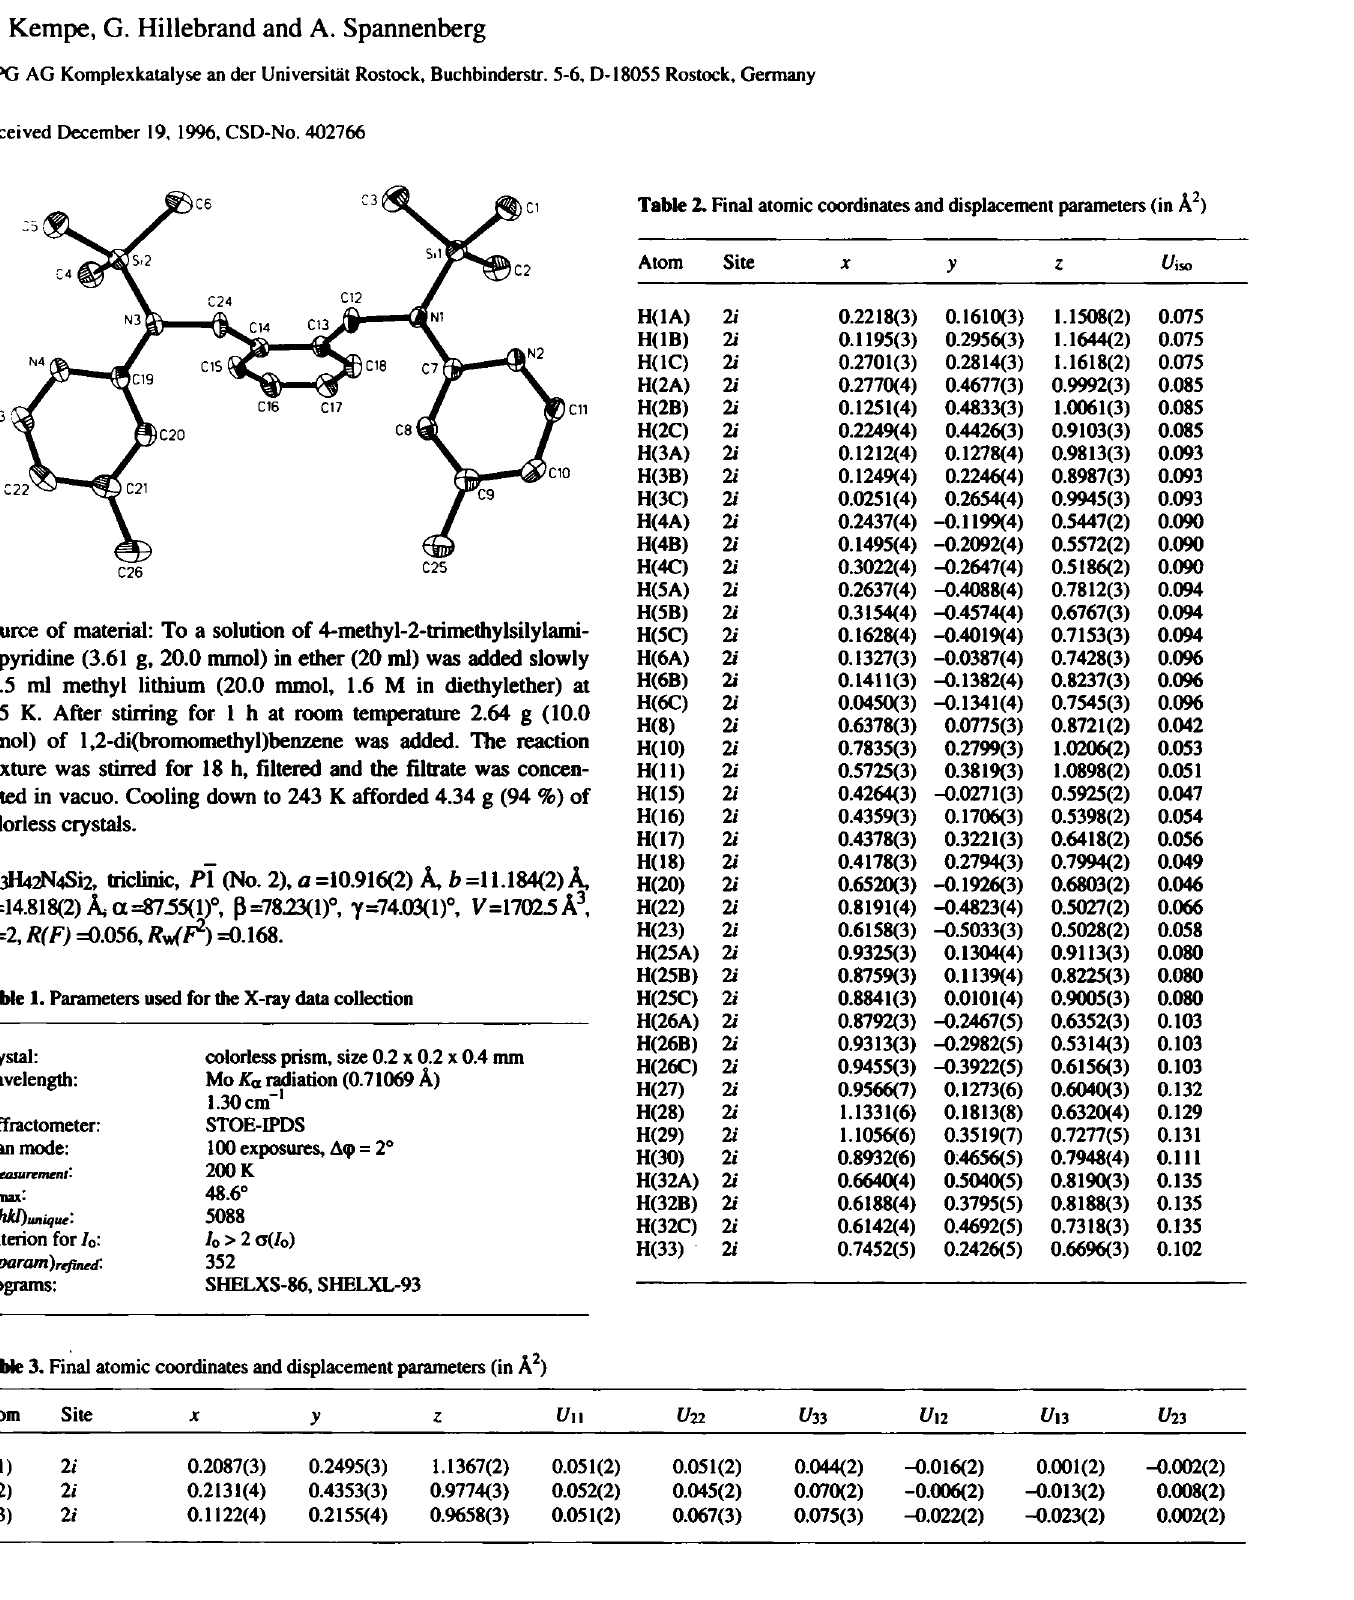
Table 2. Final atomic coordinates and displacement parameters (in Â 2 )